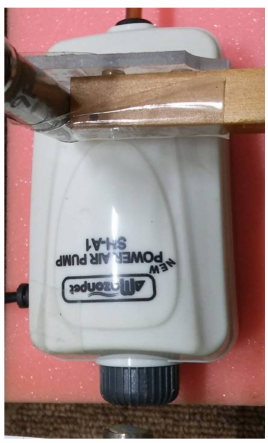
Figure 4. Small air compressor and microphones used for noise